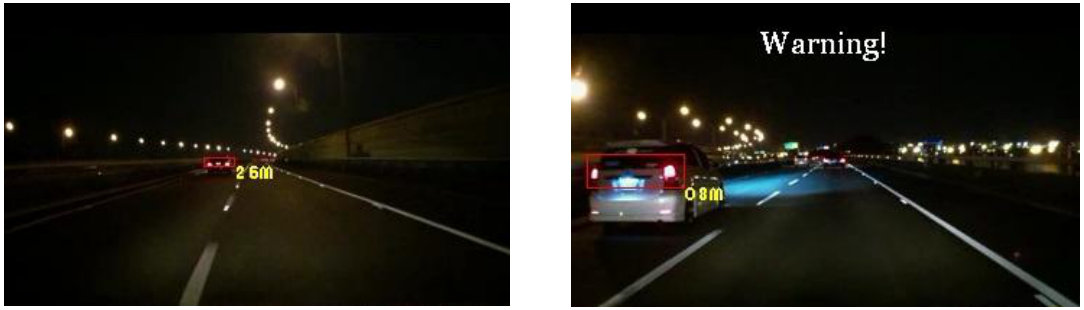
Figure 25. Results of vehicle detection and event determination for a nighttime highway under normal illumination and free-flowing traffic conditions (Test video